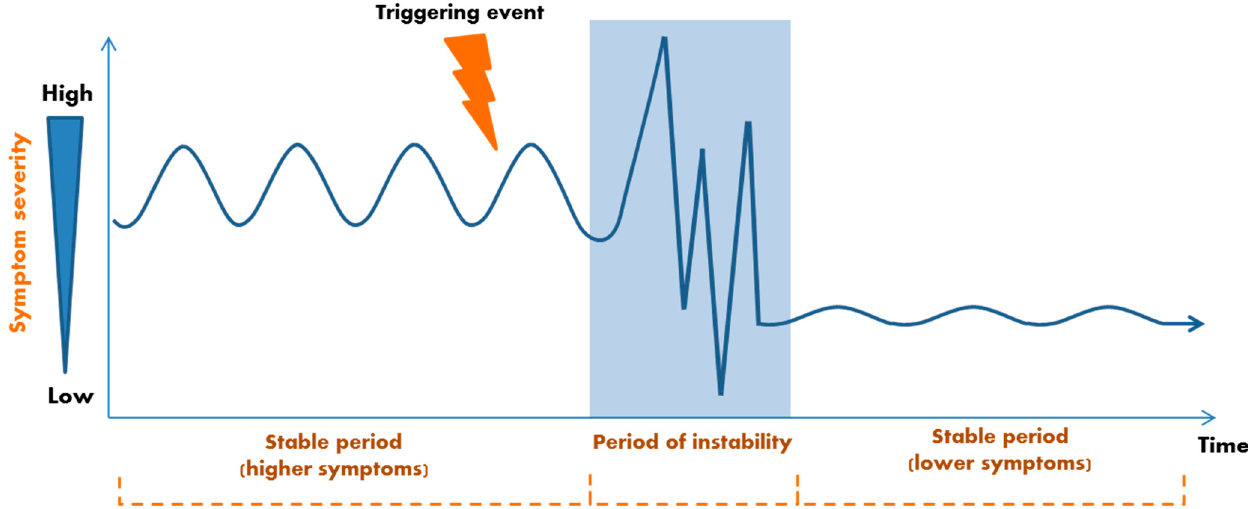
Figure 3. Schematic model: a variety of (internal or external) triggering events and stressors, such as treatment, can cause perturbations and periods of destabilization in the system and with that a qualitative shift or phase transition in symptom severity from a previously stable state. The system synchronizes and stabilizes itself after a period of instability at a qualitatively different and stable symptom level again (adapted from [104]).